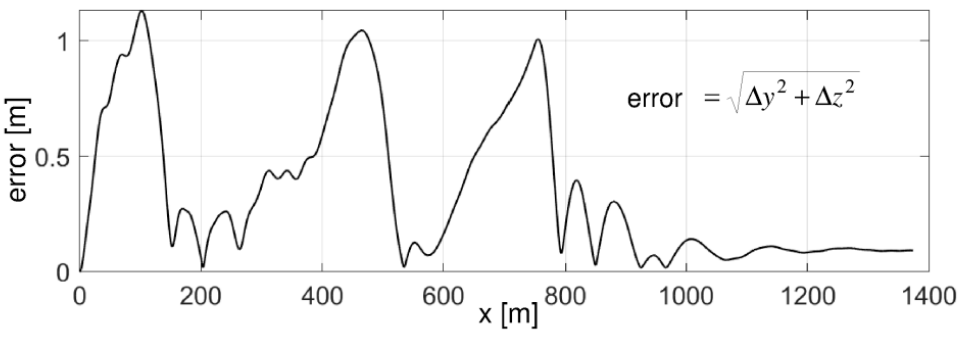
Figure 7. The control errors between the performed and set flight trajectory.